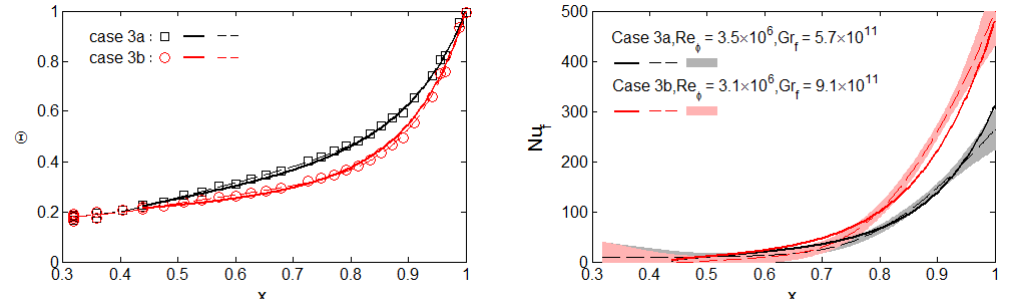
Figure 7. Distributions of temperature and Nusselt numbers for Ro ≈ 0.6. (Symbols denote measured temperatures; broken and solid lines represent experimental and theoretical results respectively; shading shows 95% confidence intervals on experimental Nusselt numbers) [4]. Aerospace 2018 , 5 , x